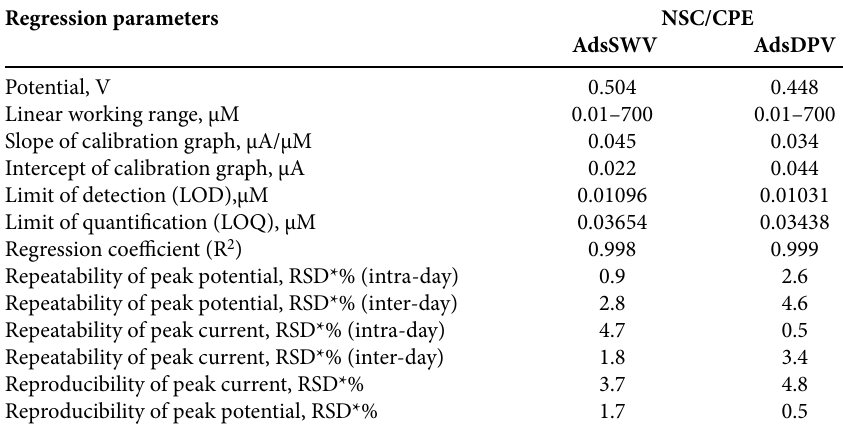
Table 2. The statistical results of regression analysis for the determination of HQ